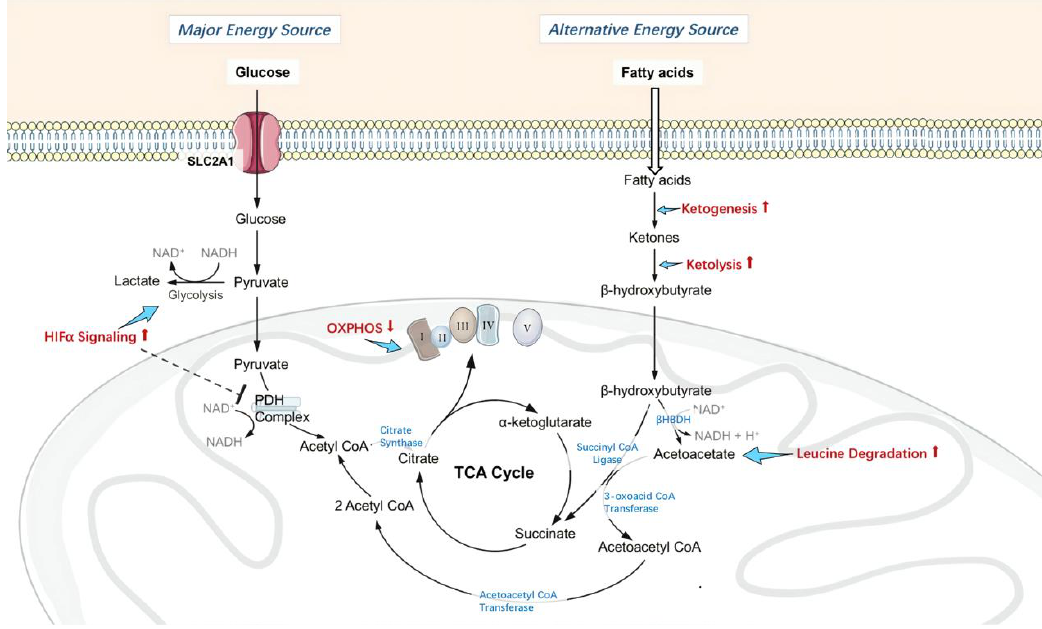
Figure 6. Changes in retinal metabolism, mitochondrial homeostasis and function. Administration of H 2 S actively inhibited pyruvate dehydrogenase (PDH) complex activity by upregulating HIF1α signaling, therefore limited using glucose as energy source, and suppressed oxidative phosphorylation by inhibiting Complex I activity, consequently increased intracellular oxygen tension under ischemia and limited ROS production during reperfusion. Furthermore, H 2 S promotes the utilization of ketone bodies as an alternative energy source, which is more energy-efficient than glucose, thus permitted continuous adenosine triphosphate (ATP) production. H 2 S enhanced the ability of retinal neurons to withstand metabolic stress induced by I/R, therefore less neuronal cell loss.